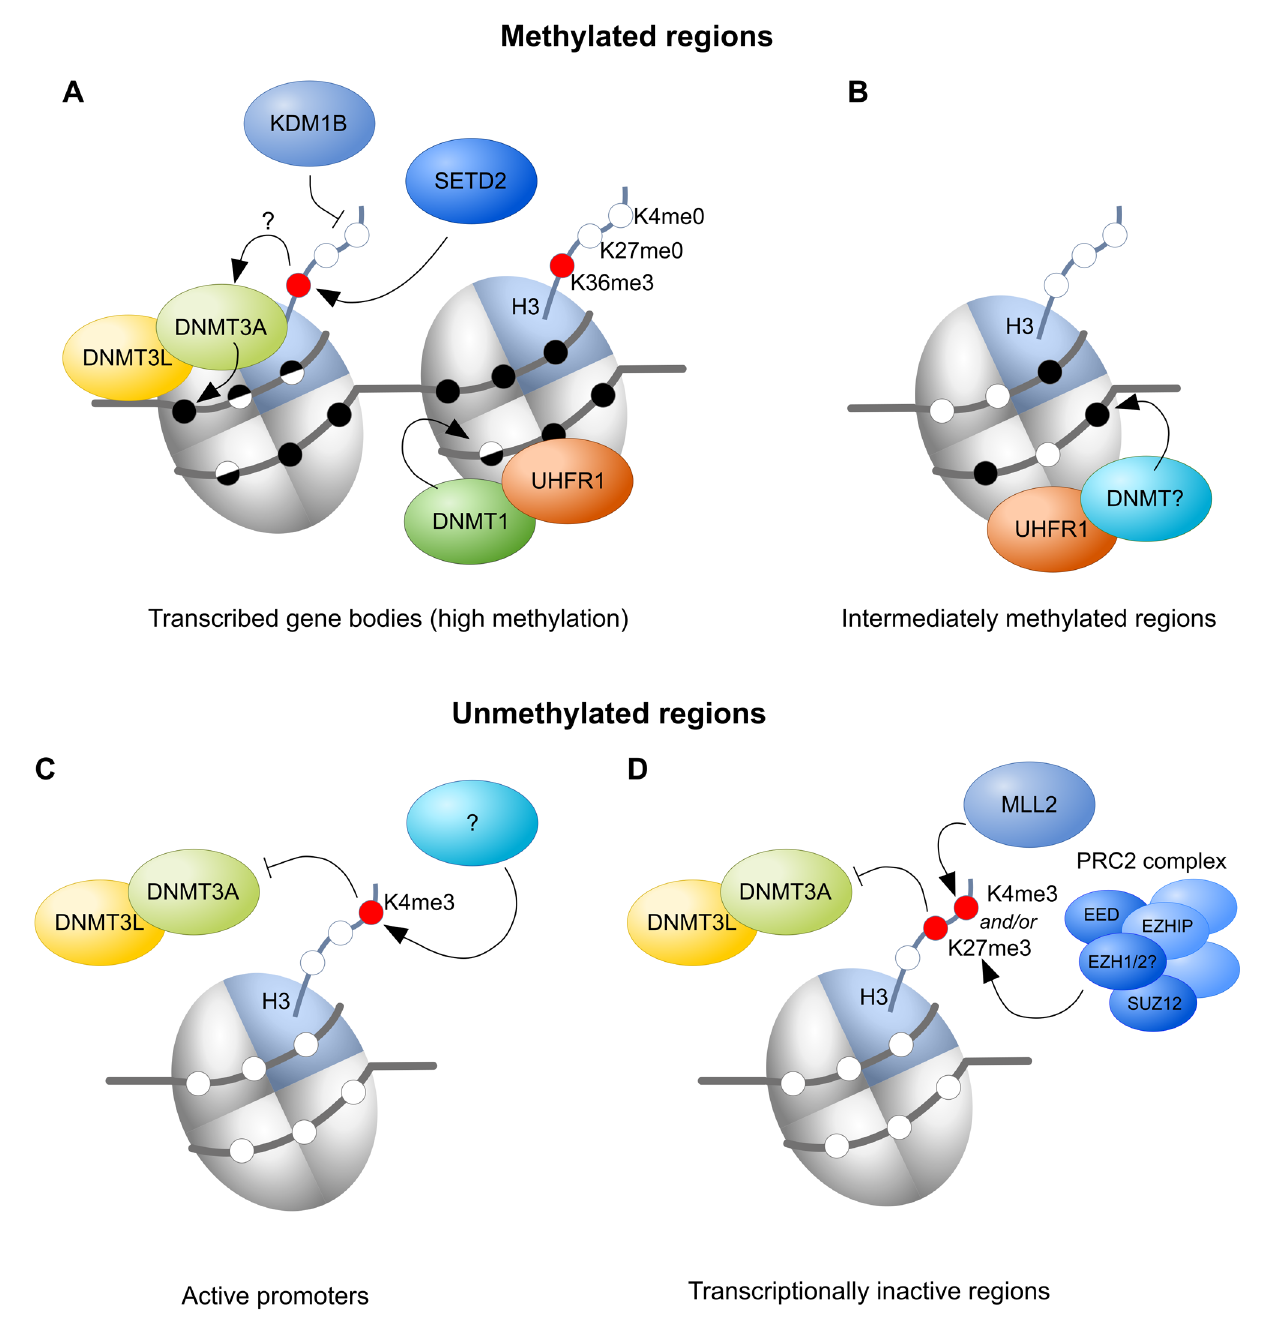
Figure 2. Models showing chromatin factors involved in DNA methyltransferase (DNMT) 3A/DNMT3L recruitment in methylated regions and factors inhibiting DNMT3A/DNMT3L binding at unmethylated regions. A ) At actively transcribed gene bodies, SETD2- mediated H3K36me3 has been proposed to recruit DNMT3A/DNMT3L, whilst lysine demethylase 1B (KDM1B) seems to be required to prevent or remove histone 3 lysine 4 (H3K4) methylation. DNMT1 is needed for methylation of hemimethylated DNA. B ) Ubiquitin-like, plant homeodomain and ring finger-containing 1 (UHRF1) is required for intermediate DNA methylation of some genic and intergenic regions, likely by recruiting one of the DNMT proteins, but the chromatin requirements are unknown. C ) At active promoters, H3K4me3 is thought to prevent DNMT3A/DNMT3L binding. D ) Transcriptionally inactive regions can be marked by mixed lineage leukaemia-2 protein (MLL2)- mediated H3K4me3 and/or polycomb repressive complex 2 (PRC2)-mediated H3K27me3, preventing recruitment of DNMT3A/DNMT3L to these regions. EED, embryonic ectoderm development; EZHIP, EZH inhibitory protein; SETD2, SET domain containing